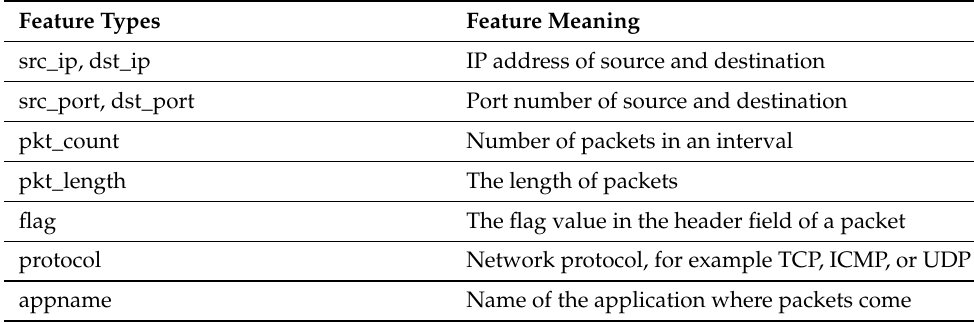
Table 1. Common features for NIDS